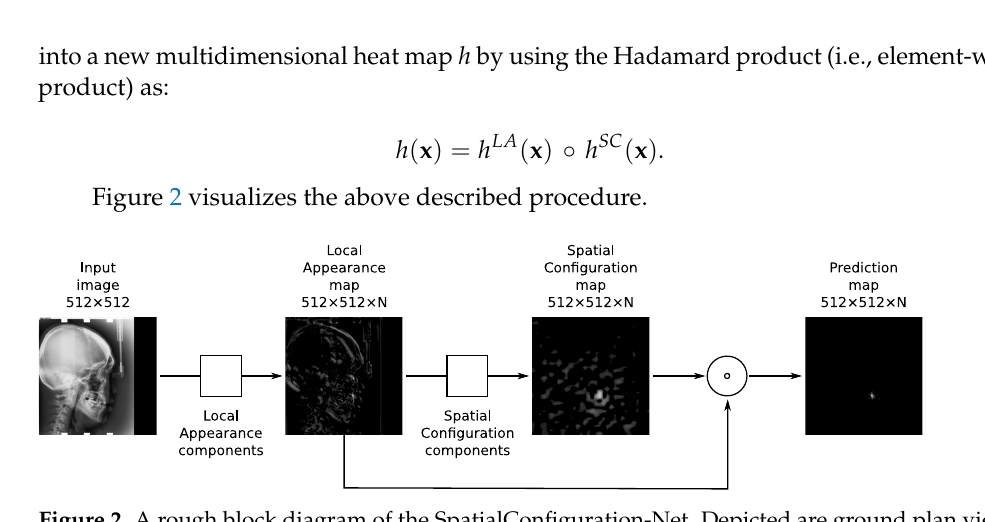
Figure 2. A rough block diagram of the SpatialConfiguration-Net. Depicted are ground plan views of maps (i.e., a single 2D map/channel is shown for a selected